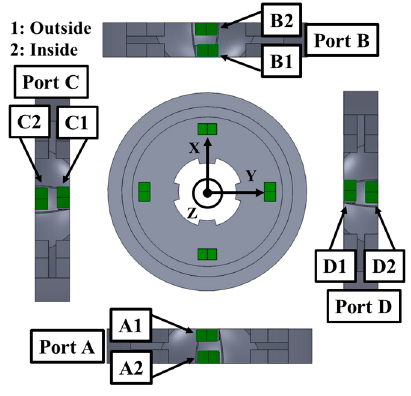
Figure 9. Arrangement of MPAs in the stator. Table 1. Excitation method of each vibration mode.